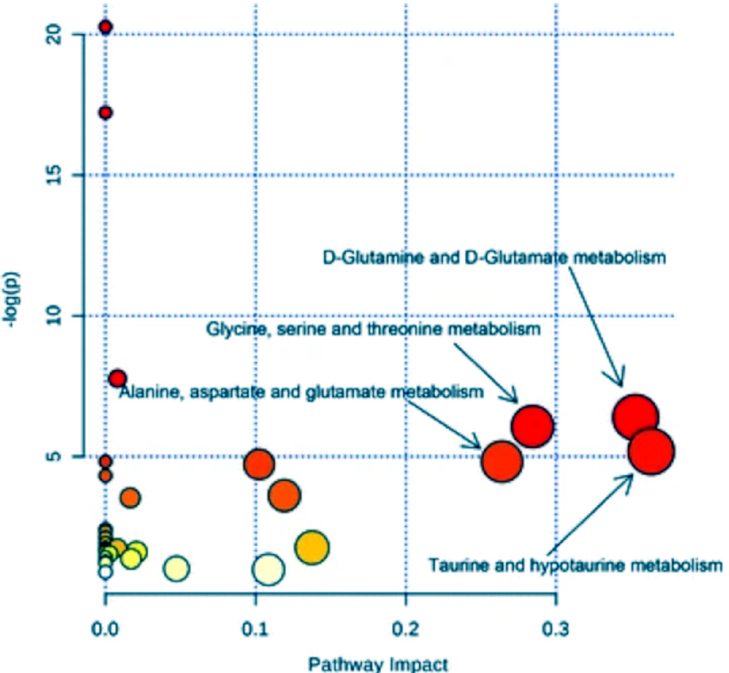
Figure 13. Pathway analysis performed on serum spectra recorded by 1 H NMR allowing the identifi- cation of main metabolic pathways associated with non-small cell lung cancer. The larger the circle, the higher the impact. The color, from red to yellow, identifies the corresponding significance. Figure reprinted from [23] under the terms of the Creative Commons Attribution 4.0 International